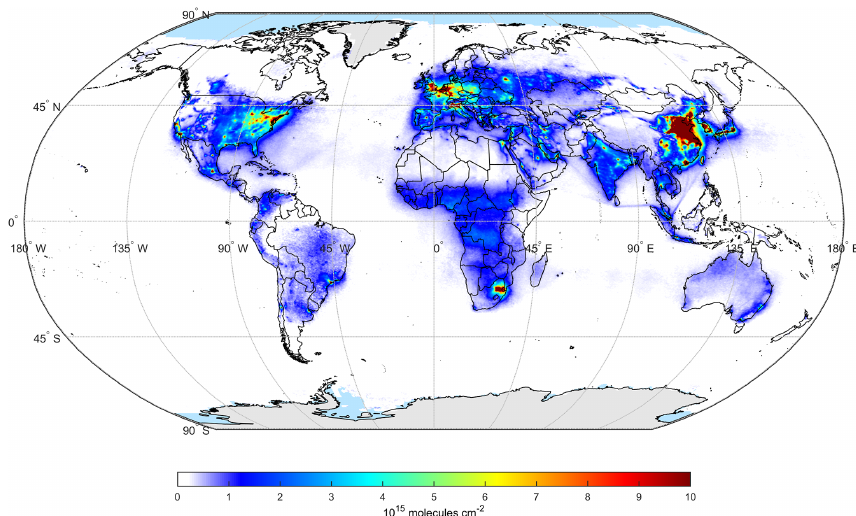
Figure 1. Global map of long-term average tropospheric NO 2 column derived from SCIAMACHY data (given in units of × 10 15 moleculescm − 2 ). The average was computed over the entire time series of SCIAMACHY data ranging from August 2002 to March 2012. The faint linear feature in the North Atlantic is not a real signal but an artefact of the retrieval process. It does not affect the analysis of trends in urban agglomerations presented